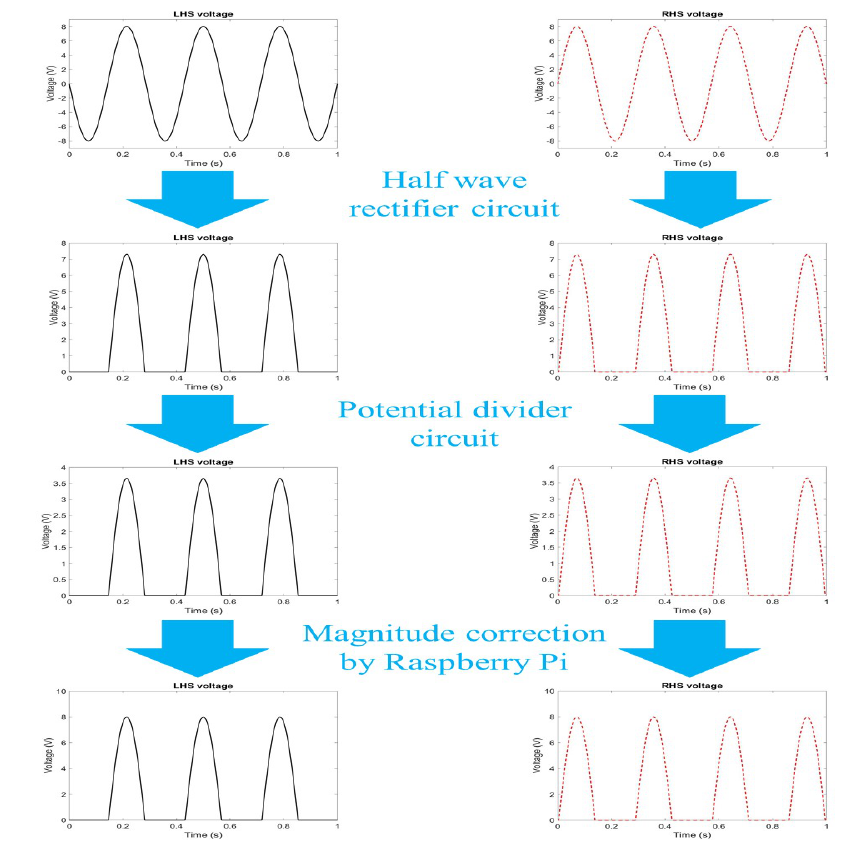
Figure A2. Manipulation of voltage by the circuits and the Raspberry